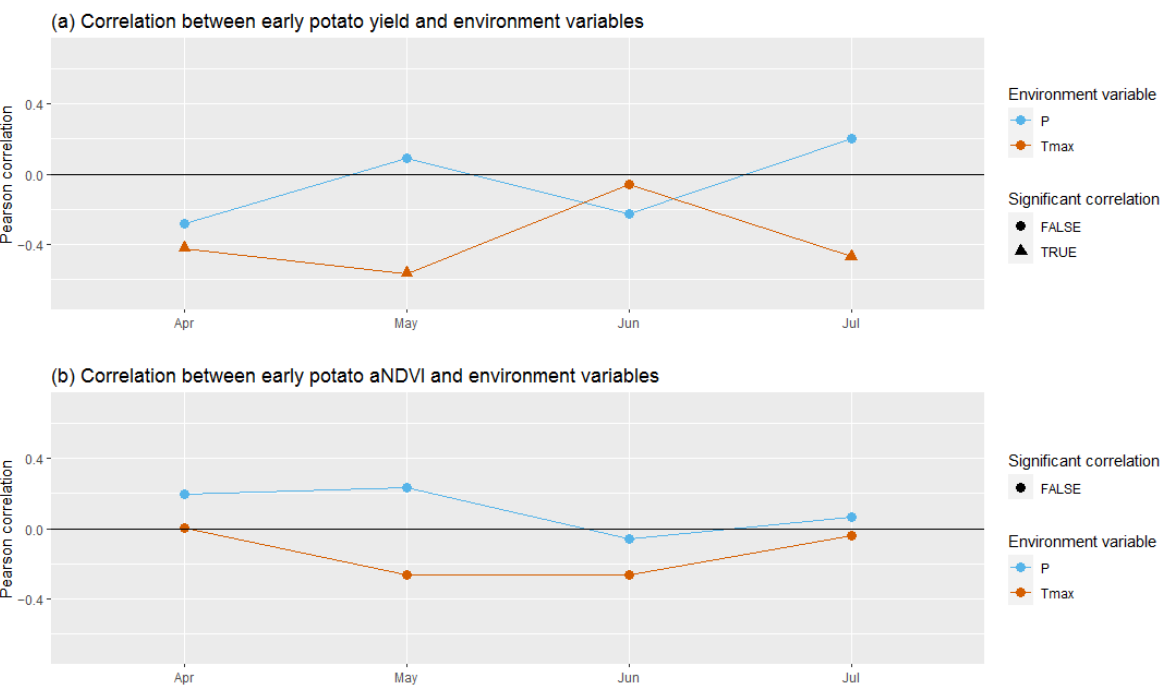
Figure 8. Pearson correlations for late potato during May–September between ( a ) yield and monthly precipitation (P), maximum temperature (Tmax) and root-zone soil water depletion (SDrz), ( b ) aNDVI and monthly precipitation (P), maximum temperature (Tmax) and root-zone soil water depletion (SDrz). Significant correlation values ( p < 0.01) are indicated with a triangle and nonsignificant correlation values ( p > 0.01) with a circle.